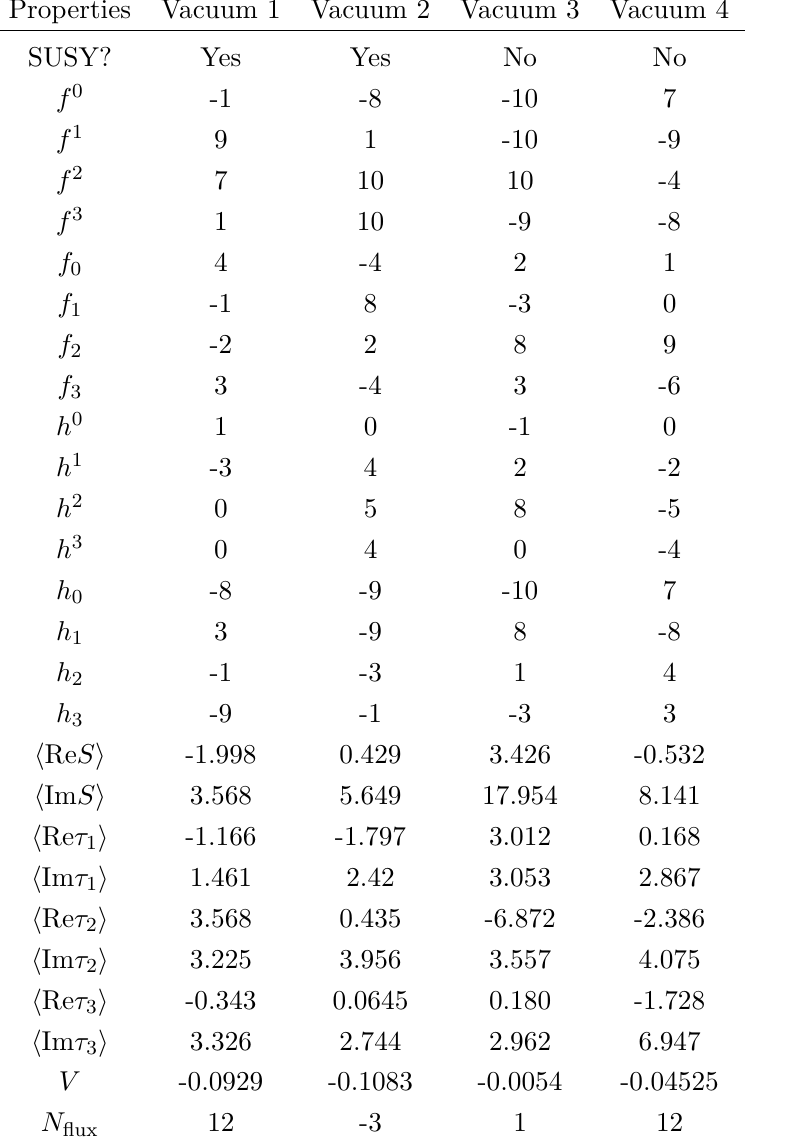
Table 3 . The benchmark points for SUSY and non-SUSY AdS vacua in the anisotropic case.